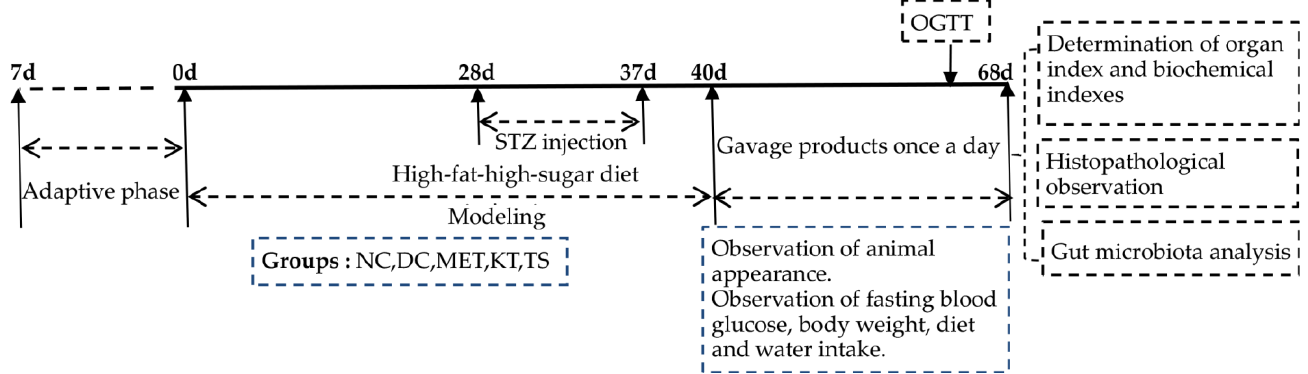
Figure 1. Schedule of the experiment.